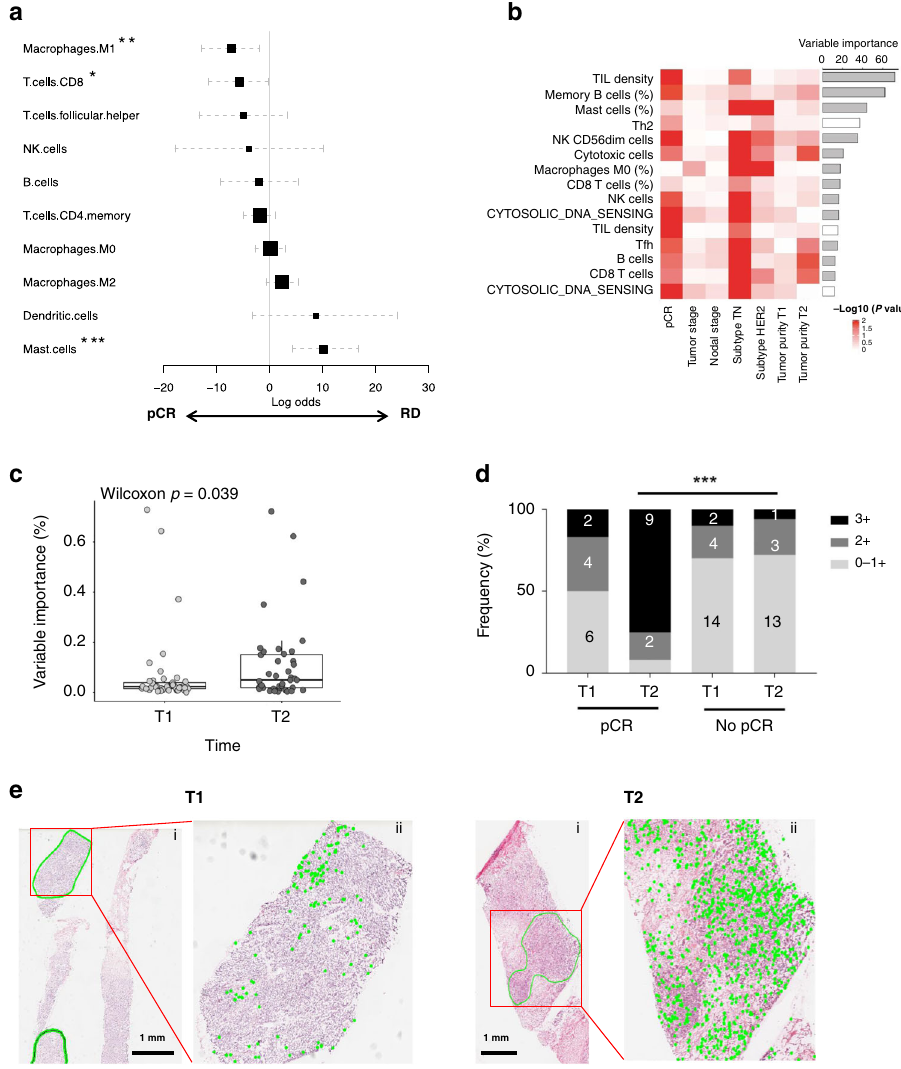
Fig. 7 Impact of immune response on treatment outcome. a Forest plot showing the associations of different immune cell fractions vs. NAC response combined T1 and T2 samples. The x -axis shows the log odds ratio of % cell fractions in pCR vs. RD. Asterisks indicate statistical signi fi cance based on multiple regression adjusting for subtype as a covariate: * p = 0.038, ** p = 0.008, *** p = 0.0008. b Independent associations between clinical factors (columns) and molecular features (rows) associated with pCR. Value in each cell represents – log10( p -value) of the association between each feature and clinical factor after adjusting for the confounding effect of other factors. Features were ranked in descending order by % variable usage as determined by bootstrapping analysis, the percentage of runs in which the elastic net model selected the variable to predict pCR status. Source data are provided as a Source Data fi le. c Comparison of variable importance estimated for T1 and T2 immune features based on bootstrapping analyses. Statistical signi fi cance was determined using two-sided Wilcoxon rank sum test. The box is bounded by the fi rst and third quartile with a horizontal line at the median and whiskers extend to the maximum and minimum value. Source data are provided as a Source Data fi le. d Distributions of intraepithelial TIL levels between T1 and T2 samples and in pCR vs. RD cohorts. Asterisks indicate statistical signi fi cance calculated by using one-sided Chi-squared test: *** p = 4.06E − 5. e H&E images of tumor biopsy sections taken from the same TNBC patient (OB-16-0006) showing an increased abundance of intraepithelial TILs between T1 baseline and T2 on-treatment. Sub-panel ii shows the tumor region annotated in subpanel i at a higher zoom with the intraepithelial lymphocytes highlighted in green. H&E staining was only performed once on tumor biopsy Methods were prospectively taken before treatment (T1). A second core biopsy was taken Patient enrollment and sample collection . This study was reviewed and three weeks after the fi rst cycle of AC (T2) while a third tumor sample was taken at surgery following 6 months of treatment (T3). approved by the Institutional Review Board (IRB) of Samsung Medical Center Fresh frozen tissue specimens were collected from 201 of the 210 recruited (SMC), Seoul, Korea (IRB No. 2014-11-015) with informed consents from the patients. All the biopsy samples were processed immediately or within 15 min after patients for the research use of clinical and genomic data. Clinical study was acquisitions. Samples at surgery (T3) were grossly examined and taken at the registered with www.clinicaltrials.gov (NCT02591966). All patients were diagnosed operating table just after the removal of the specimen. We excluded specimens that with histologically con fi rmed invasive breast cancer and treated at SMC. Patients were invisible, had very small, scattered tumors or contained mostly necrotic or were treated with a standard neoadjuvant chemotherapy [AC-D(H)] protocol of fi brotic scar-like tissue at the time of gross examination. Most of the samples after four cycles of doxorubicin plus cyclophosphamide (AC) combination che- breast conserving surgeries were sent for specimen mammography to ensure the motherapies followed by four cycles of docetaxel (T) chemotherapy. In accordance clips were located at the central area of the tumors before the neoadjuvant with ASCO guidelines, HER2 + BC patients were treated with docetaxel plus chemotherapy according to the protocol of SMC. trastuzumab after AC. For each patient, tumor core biopsy and matched blood